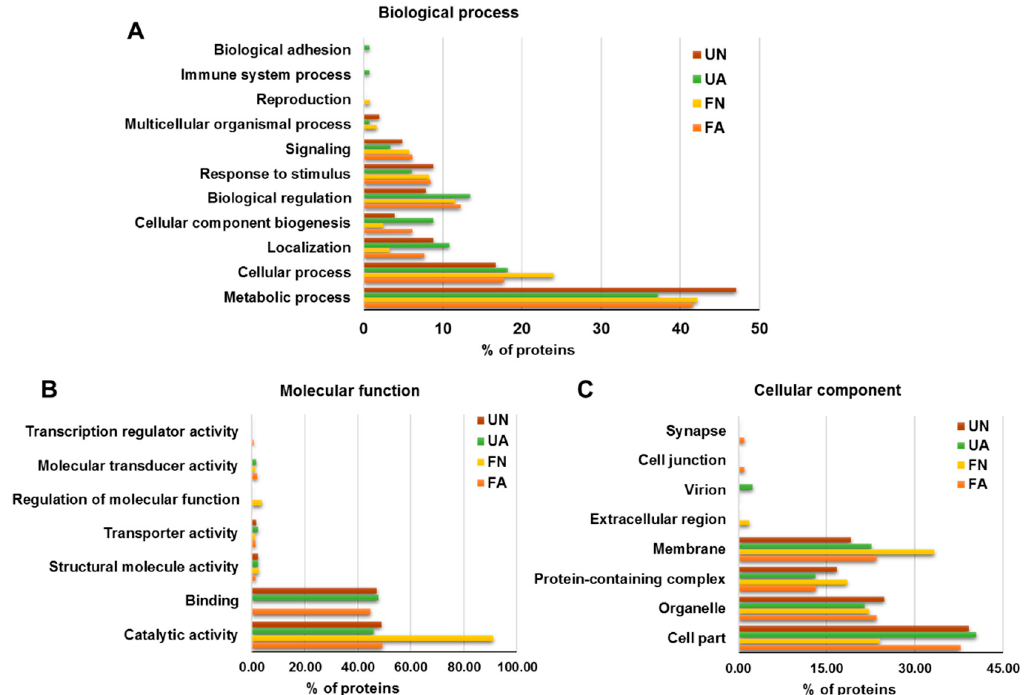
Figure 5. GO analysis of PRM proteins detected exclusively in each group analyzed.